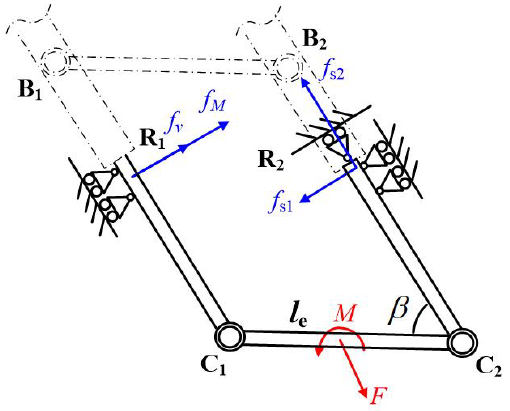
Figure 7. Reaction forces of the prismatic joints in the planar PLMEs